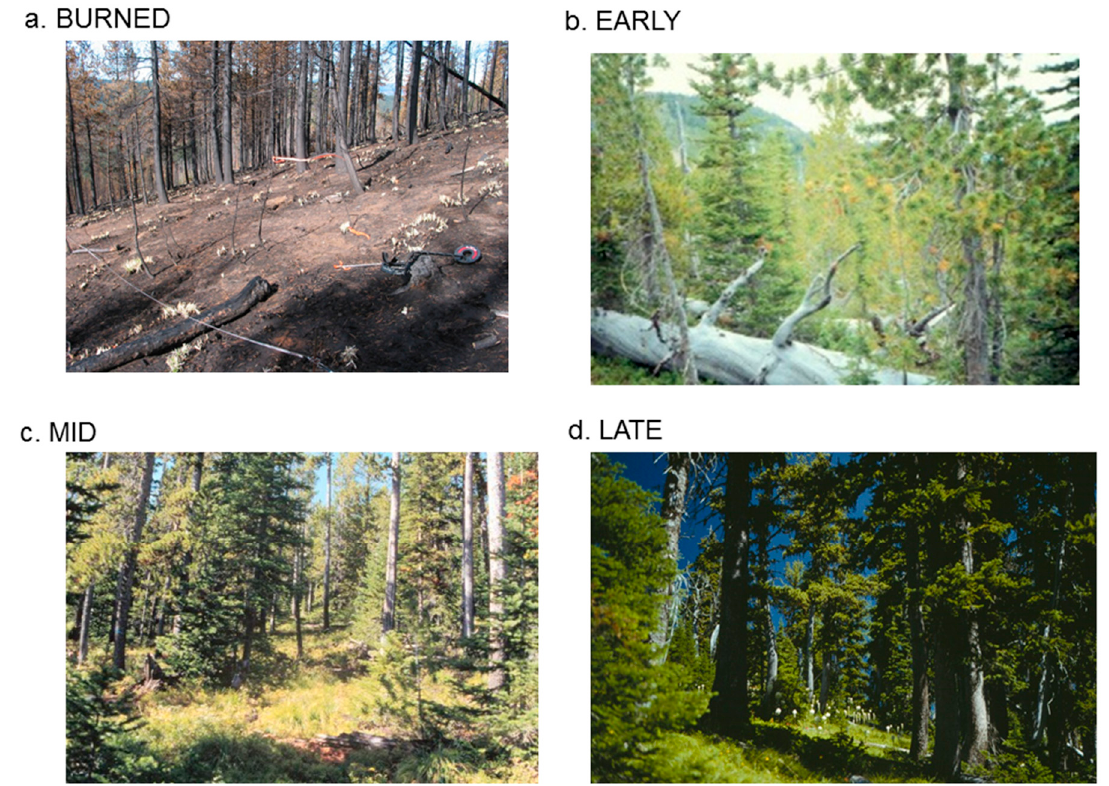
Figure 4. Four of the eight stand types used to stratify wildfire management actions. ( a ) recently burned stands, ( b ) early seral stands, ( c ) mid-seral stands, and ( d ) late seral stands that contain significant fir, spruce, mountain hemlock.